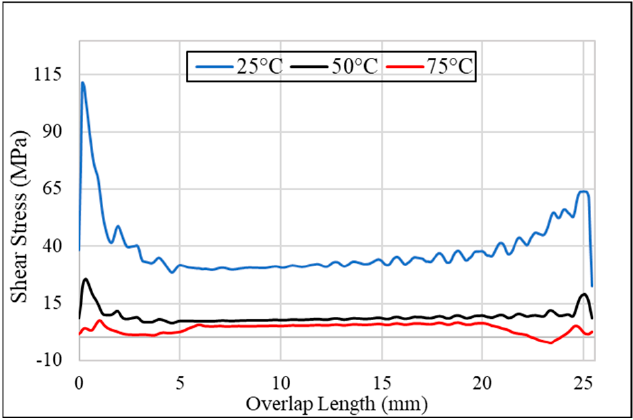
Figure 13. Shear stress distribution at location D of SLJ with neat adhesive at different temperatures.